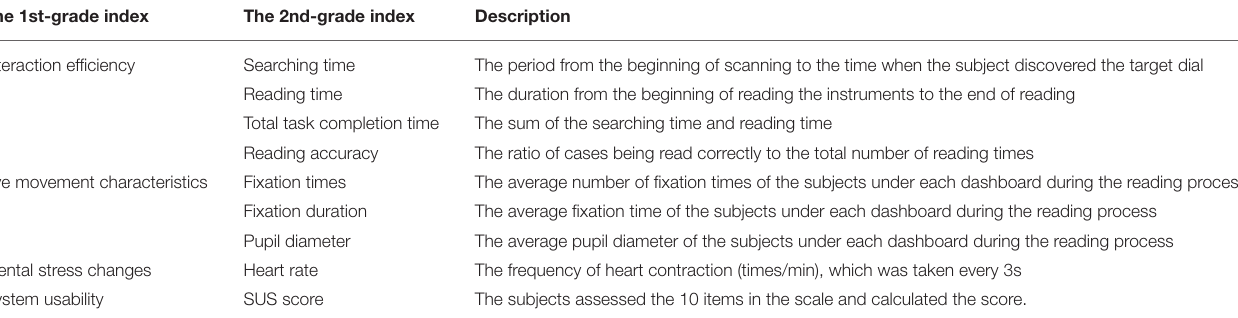
TABLE 1 | Dashboard interaction evaluation index system of shared cars.